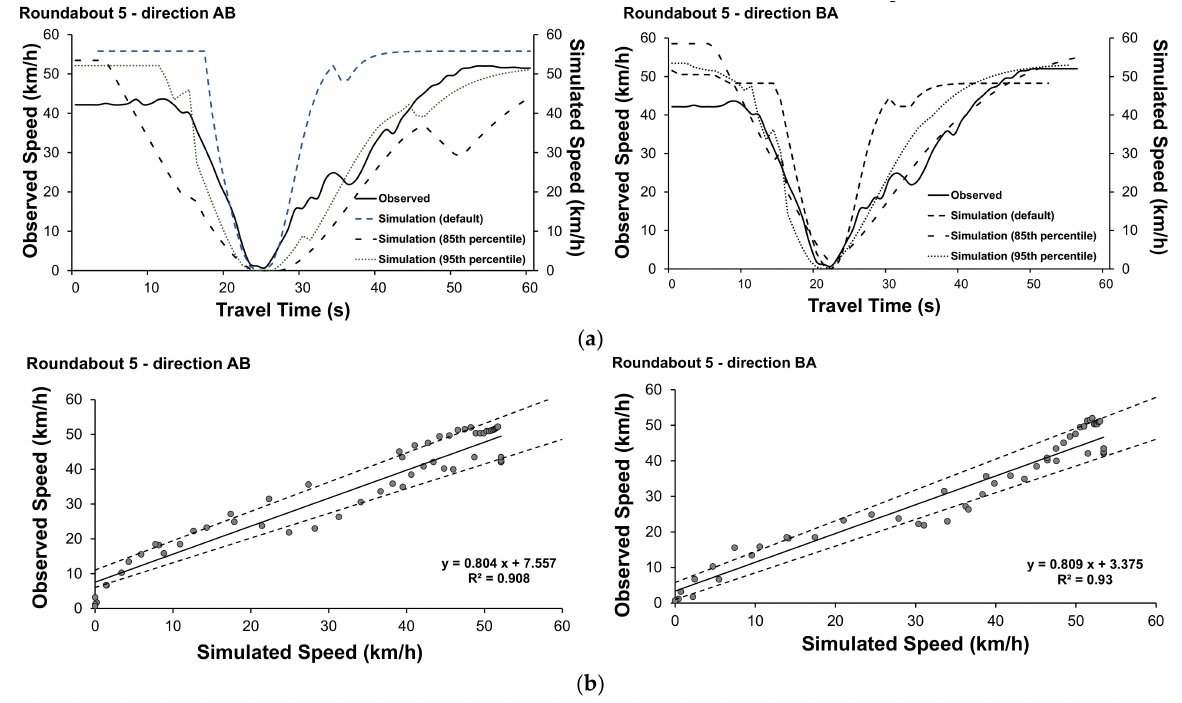
Figure 7. Observed vs. simulated data at Roundabout 5 (directions AB and BA in Figure 2e): ( a ) speed profiles; ( b ) regression line of observed vs. speeds simulated under calibration with 95th percentile parameters. Note: observed stands for observed data; simulation (default) stands for default data; simulation (85th percentile) or simulation (95th percentile) stand for simulation under parameters calibrated with the mean values of the 85th or 95th percentiles of the values of acceleration and deceleration observed in the